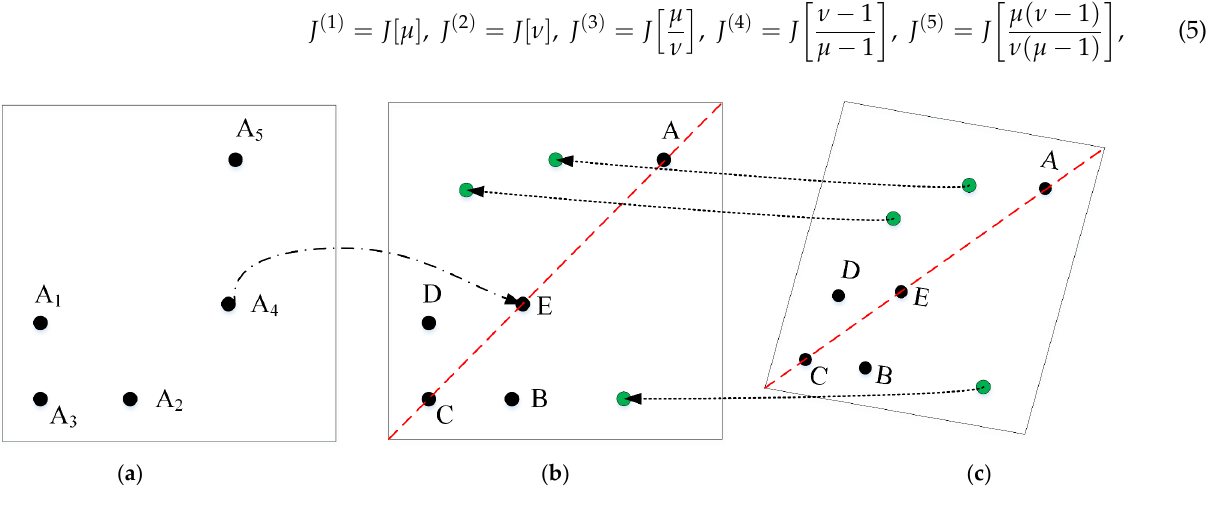
Figure 4. Five coplanar points. ( a ) Common coplanar points; ( b ) template points with three collinear points; ( c ) template points under projective deformation.